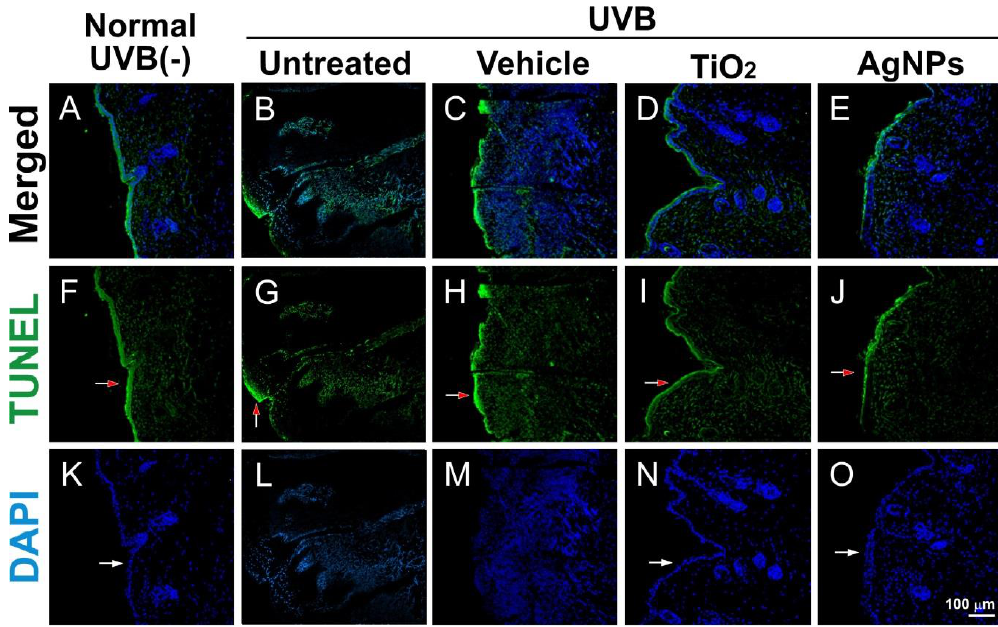
Figure 7. Fluorescence microscope images of mouse tissue sections. Fluorescence microscope images ( A – O ; merged A – E ) revealed the distribution of skin cell nuclei (4′,6-diamidino-2-phenylindole (DAPI); K – O ) relative to apoptotic cells (terminal deoxynucleotidyl transferase deoxyuridine triphosphate (dUTP) nick end labeling (TUNEL); F – J , red arrows indicate the green areas) in mouse tissue sections after various treatments. The margins of the stained cell nuclei (white arrows) became unclear after UVB irradiation in the UVB vehicle group ( L and M vs. K , N , and O ). Scale bar = 100 µm.